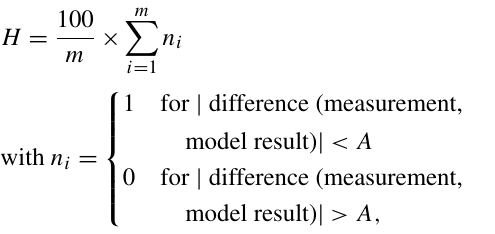
Fig. A1 that the variation in boundary layer height is gener- ally